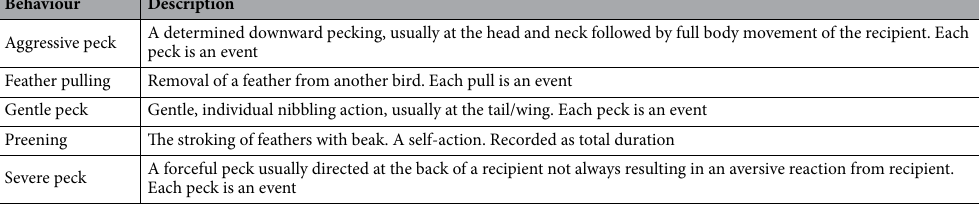
Table 1. Social feather pecking test. Ethogram used for behaviour